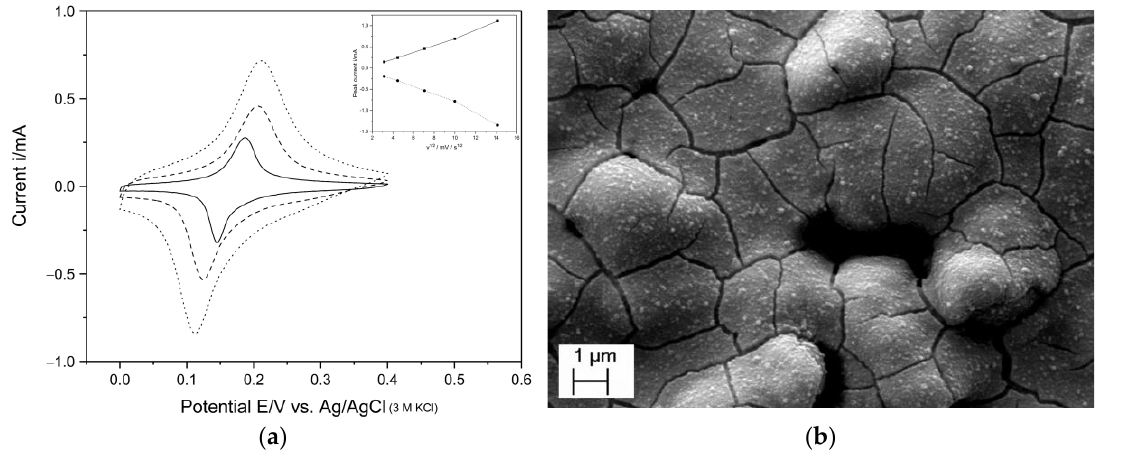
Figure 1. ( a ) CVs of PrBl-modified SPEs in 0.1 M HCl and 0.1 M KCl recorded for three different deposition times of 10, 40, and 100 s (solid = 10 s; dashed = 40 s; dotted = 100 s), recorded at a sweep rate of 50 mVs −1 . Inset: anodic (solid) and cathodic (dotted) peak current vs. the square root of the scan rate; ( b ) SEM image of an SPE modified for 40 s with PrBl.